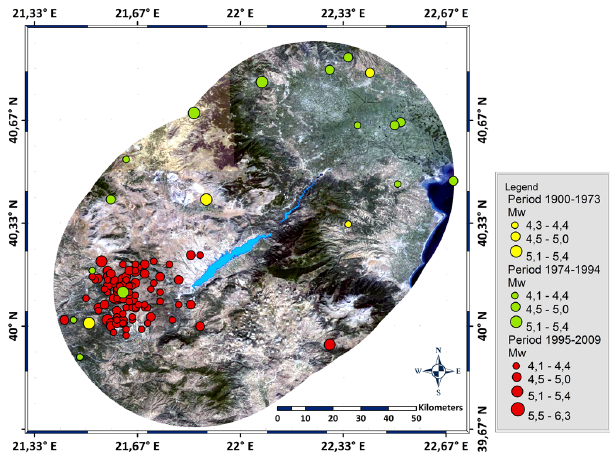
Fig. 2. Spatial distribution of seismicity ( M s ≥ 4) for the period